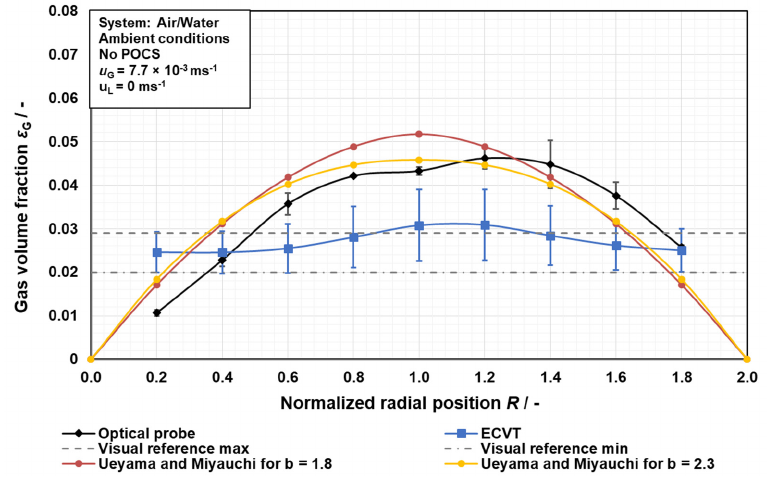
Figure 11. Comparison of the different measuring methods: ECVT ( blue ), A2PS-B-POP optical probe ( black ), volume expansion method ( visual reference ); min and max ( gray ) and the correlation after Ueyama and Miyauchi [44] for b = 1.8 ( red ) and b = 2.3 ( yellow ) in the empty pipe.